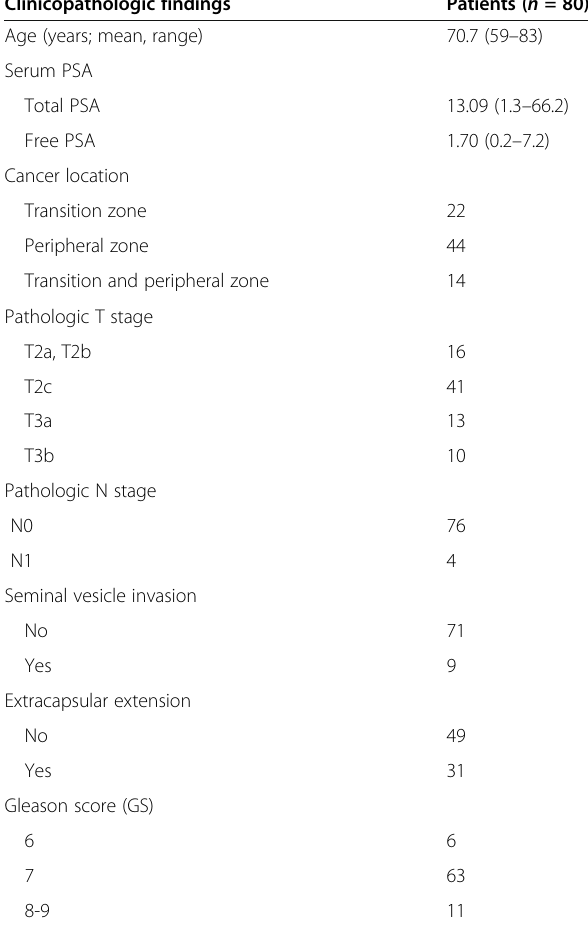
Table 1 Baseline characteristics of enrolled patients with pathologically proved prostate cancer Clinicopathologic findings